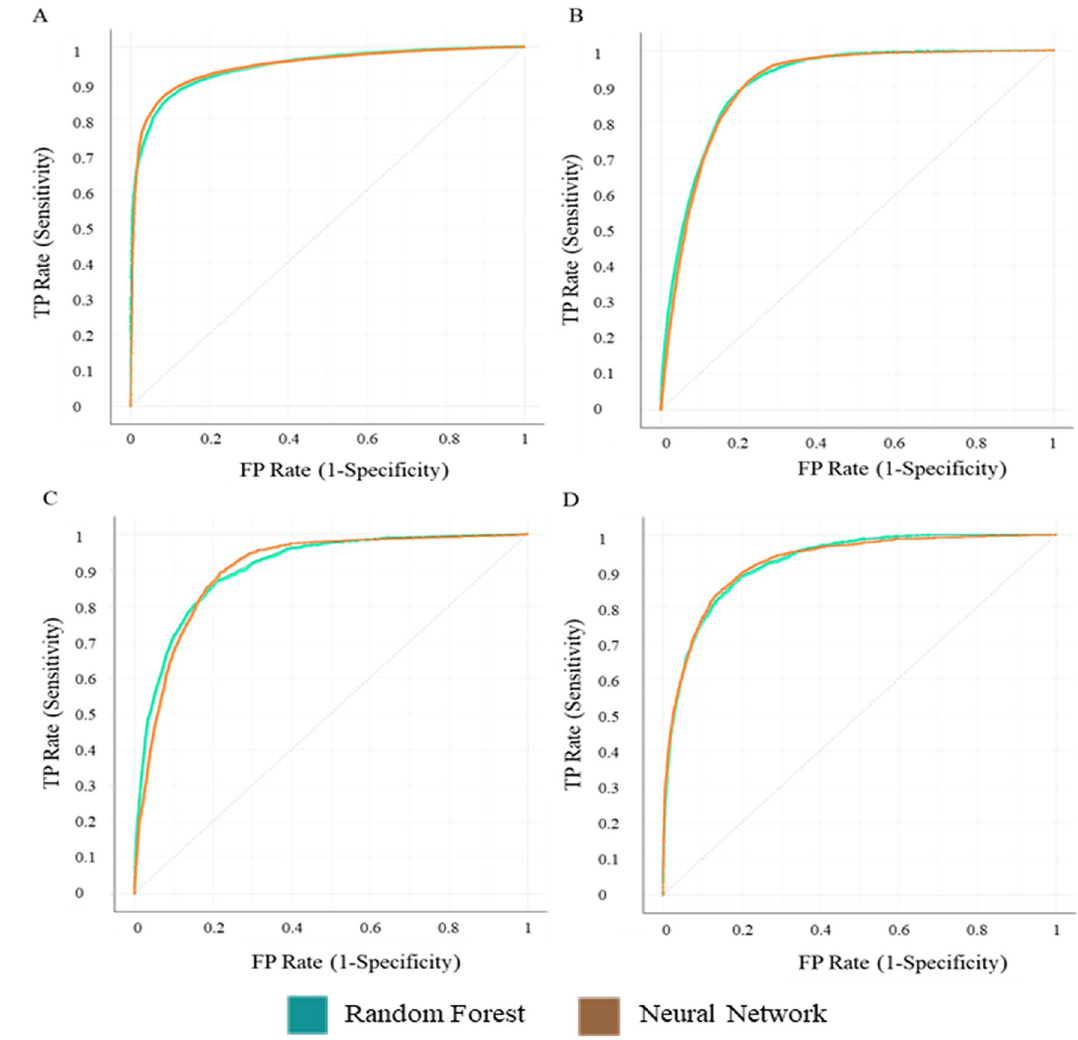
Figure 1. ROC curves of the Neural Network and Random forest models for detection of each individual sleep stage. ( a ) Awake stage, ( b ) combined light sleep stages N1/2, ( c ) slow wave sleep- N3 stage and ( d ) REM sleep stage. Figure created using Orange (version 3.26) https:// orang edata mining.